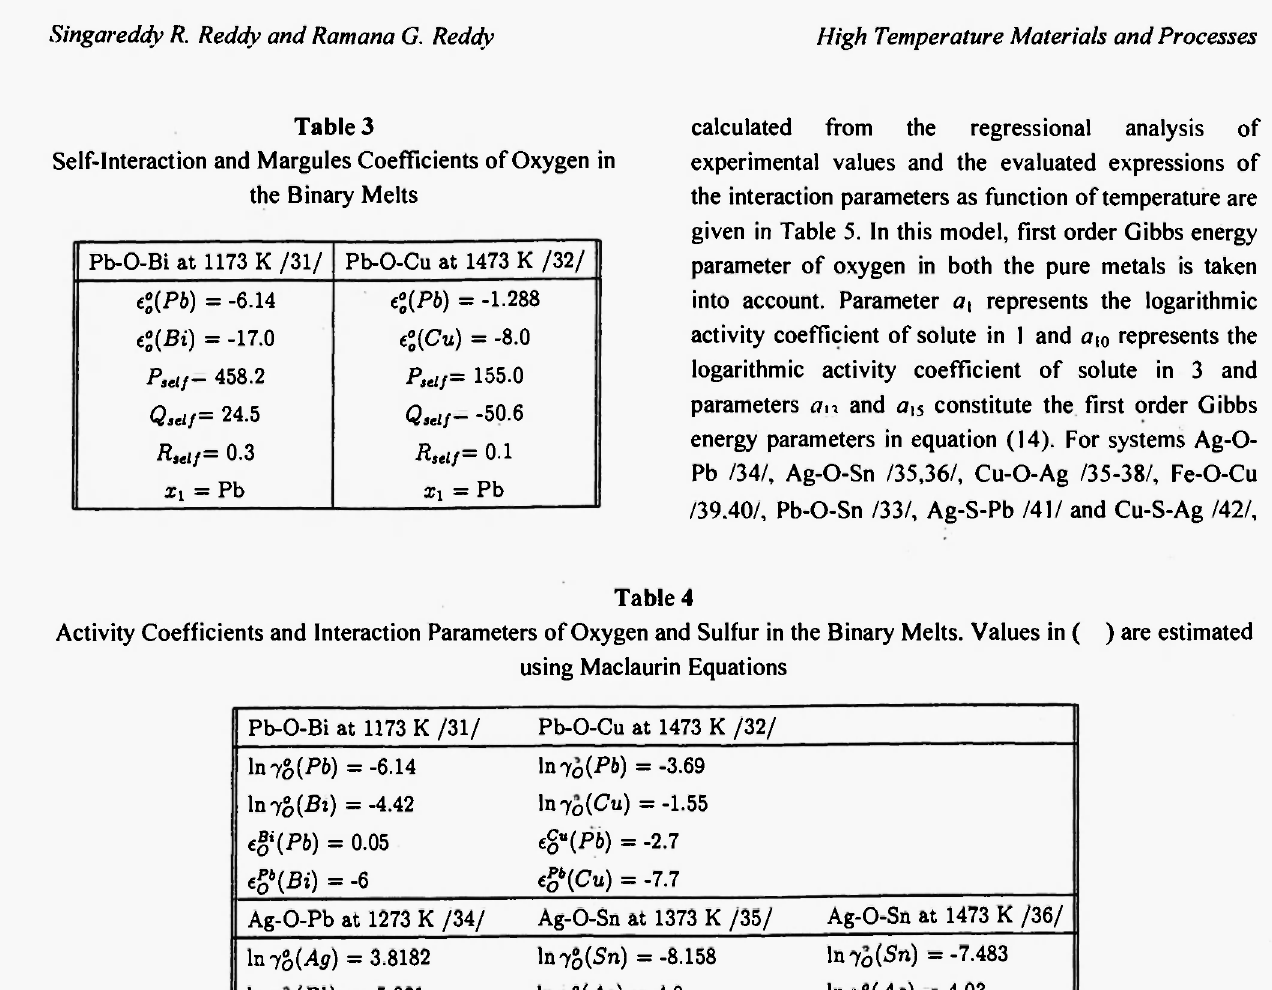
Activity Coefficients and Interaction Parameters of Oxygen and Sulfur in the Binary Melts. Values in ( ) are estimated using Maclaurin